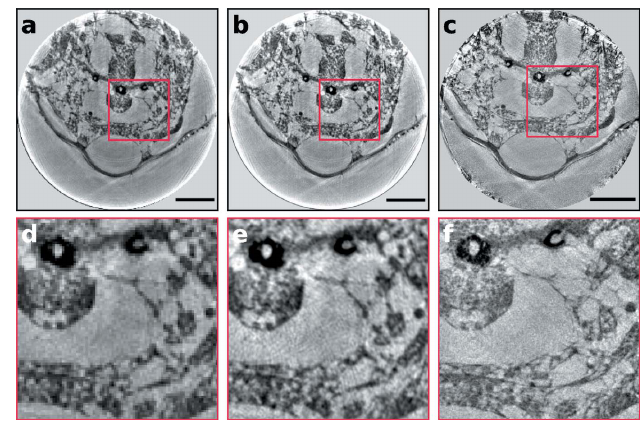
Figure 2 Reconstructed slices of the same tardigrade specimen imaged with Zernike phase contrast and the same optics but recorded with two different detectors. ( a ) Recorded with the LAMBDA. ( b ) Projections recorded with the LAMBDA and upsampled by a factor of four prior to the tomographic reconstruction. ( c ) Tomographic slice acquired with the Hamamatsu camera. Panels ( d )–( f ) show the magnified ROI indicated by the red boxes in ( a )–( c ). Note that the sample has been removed from the rotation axis between the two scans and may not show the exact same region. No filtering or further post-processing applied. The scale bar indicates 10 m